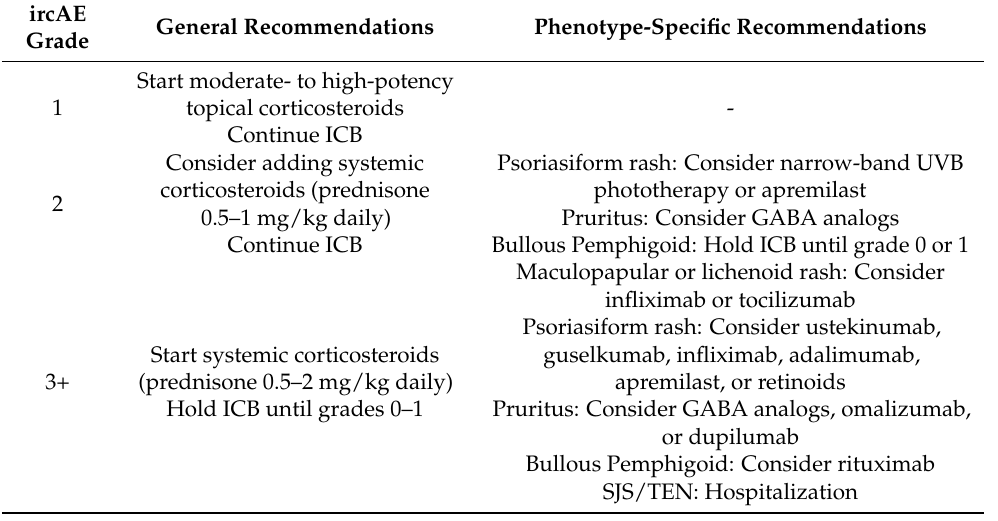
Table 4. Management recommendations for ircAEs.